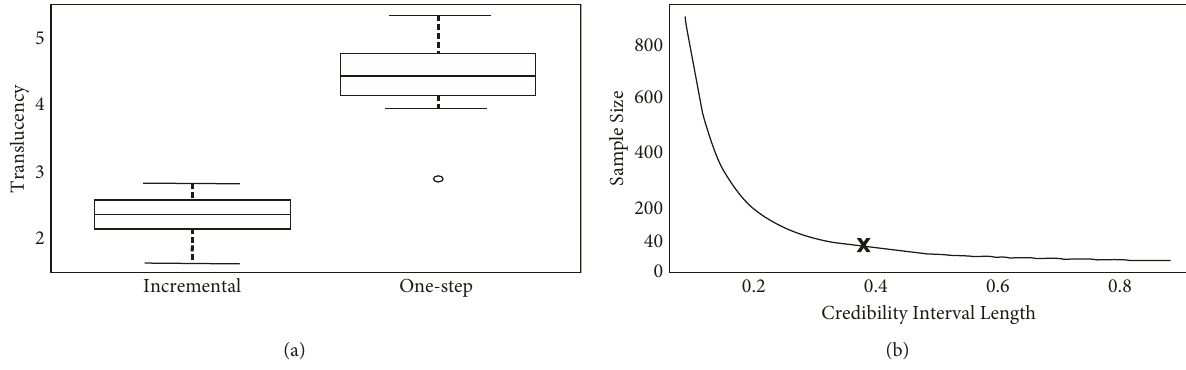
Figure 1: Results for the pilot sample using both groups (a) and sensitivity plot for the optimal sample